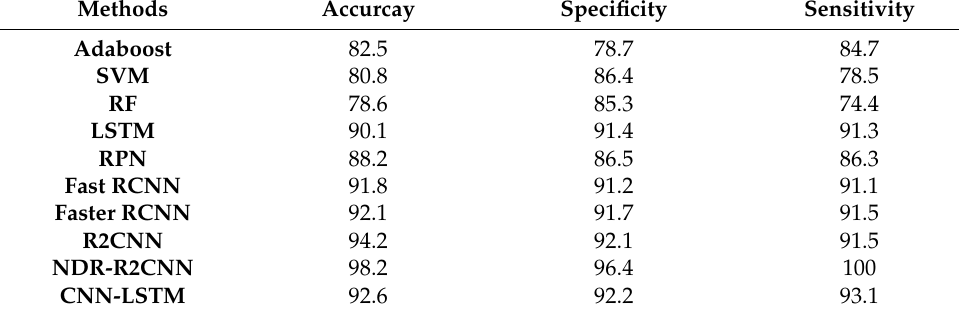
Table 4. Comparative results for various